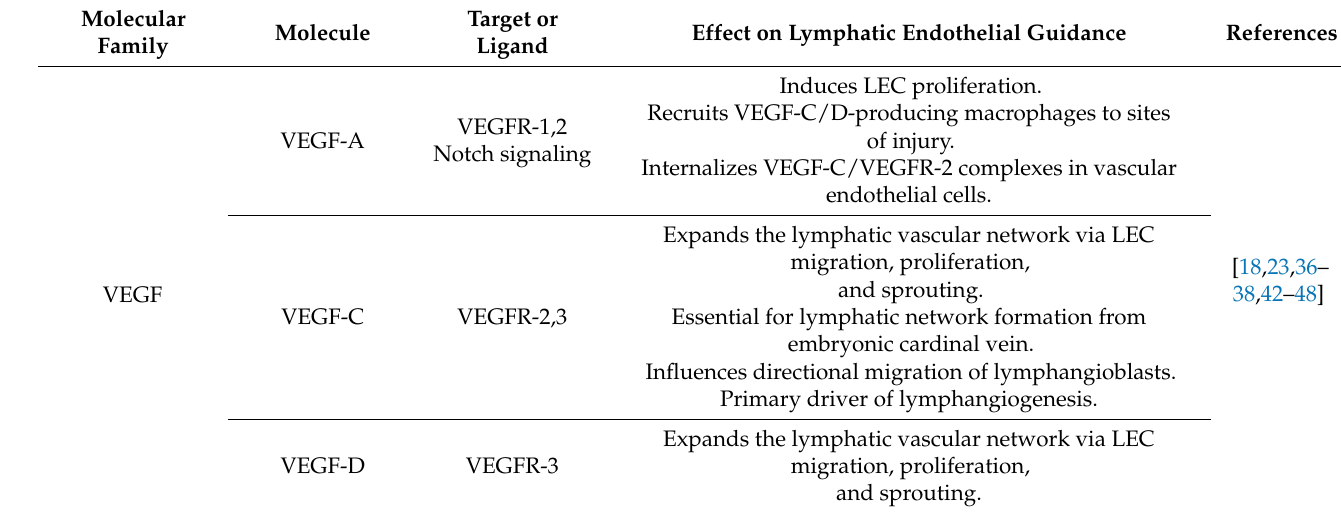
Table 1. Guidance molecules that mediate